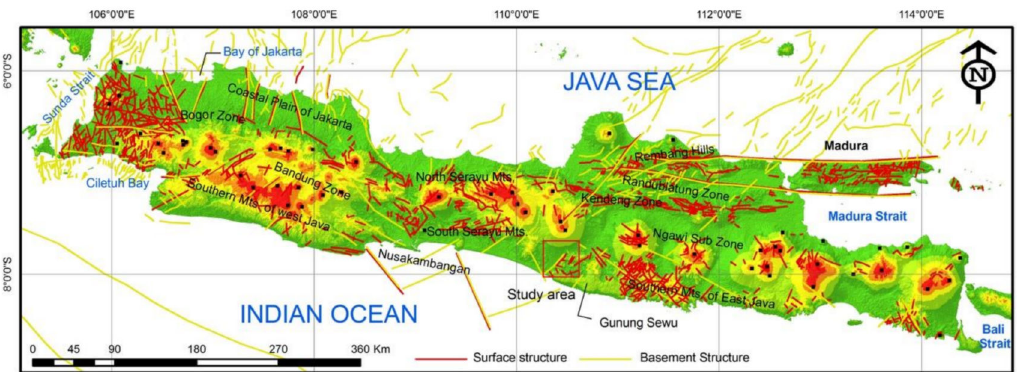
Figure 3. Fault configuration of Java (modified from